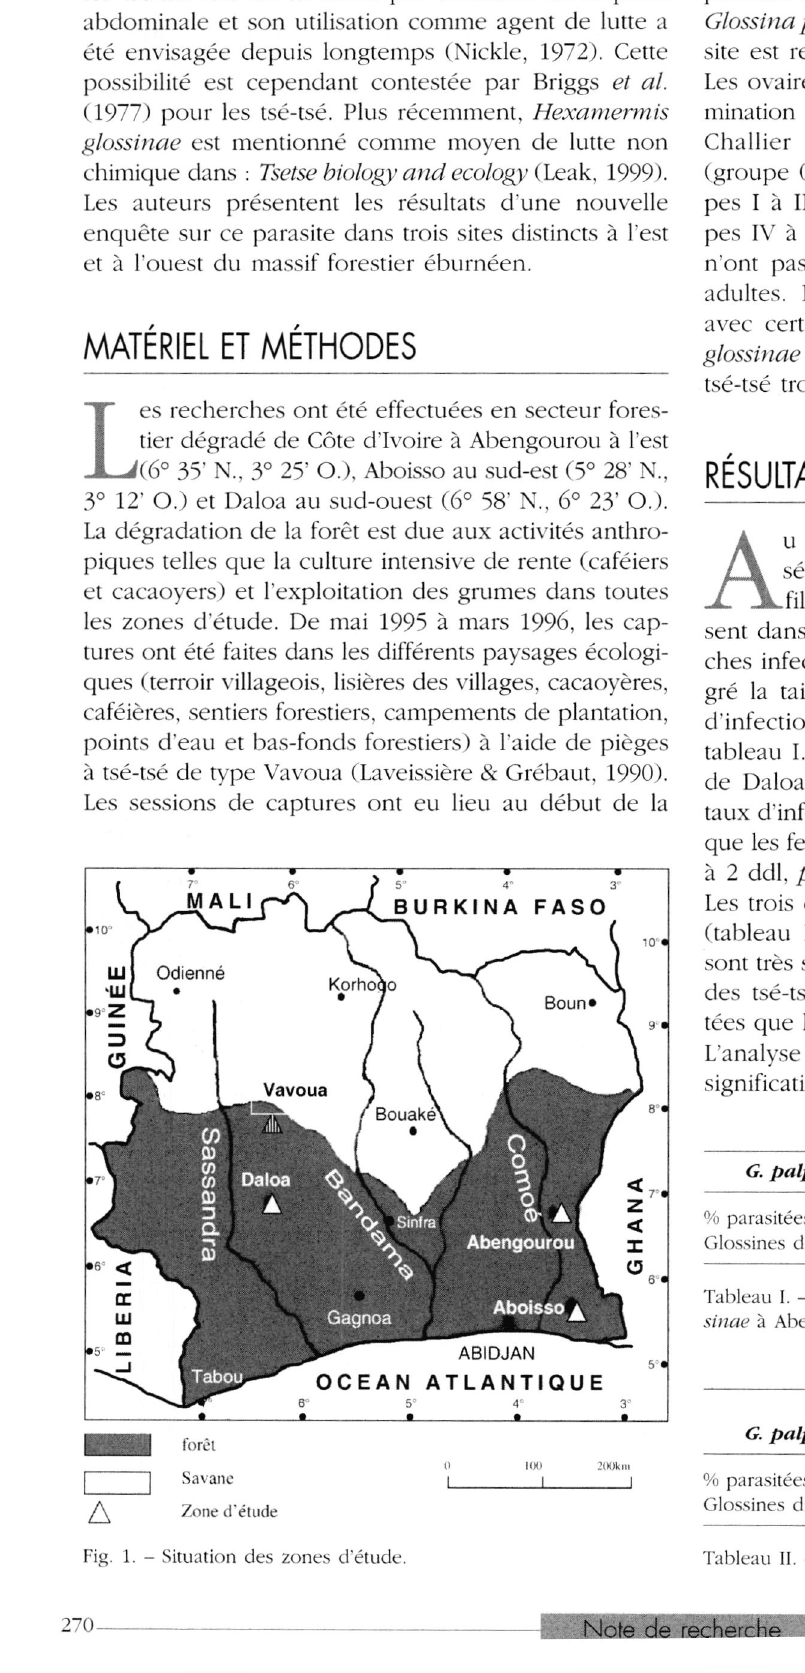
Tableau II. - Variations de l'infection suivant l'âge des